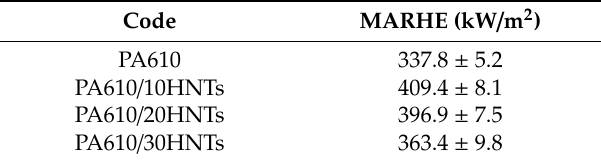
Table 4. Summary of results of maximum average heat emission index